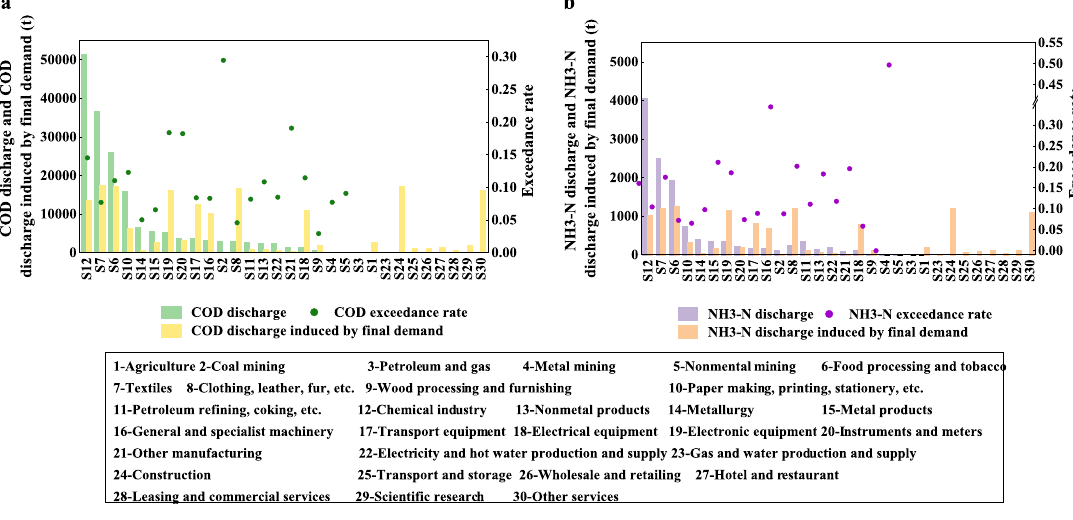
Fig. 4 Comparison of the pollution discharge, pollution discharge induced by fi nal demand, and pollution exceedance rate. a COD and b NH 3 -N. The coloured bars denote the amount of pollution discharge and pollution discharge induced by fi nal demand while the dots represent the pollution exceedance